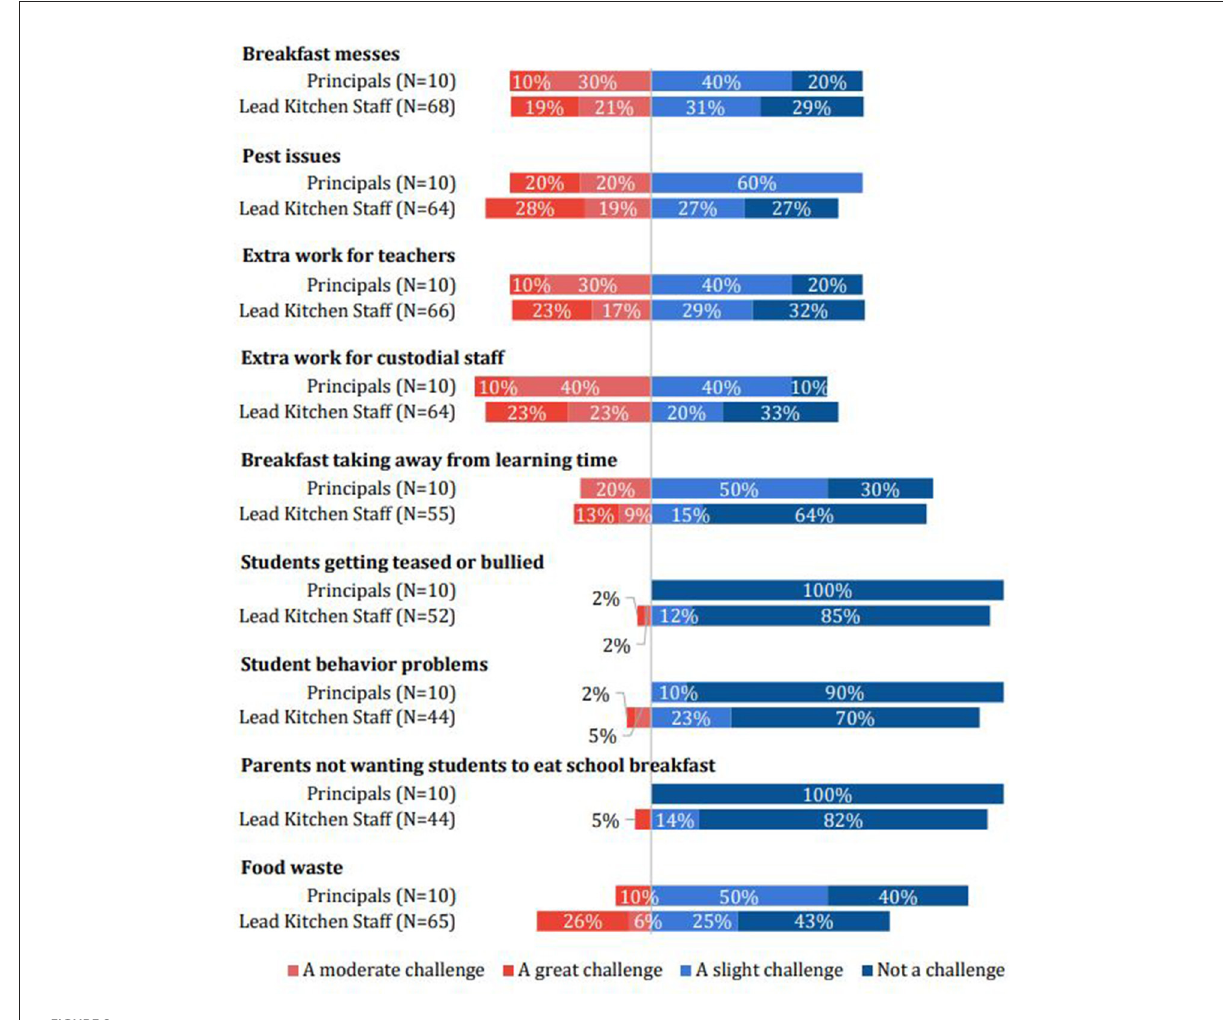
FIGURE2 Perceived negative implementation determinants by